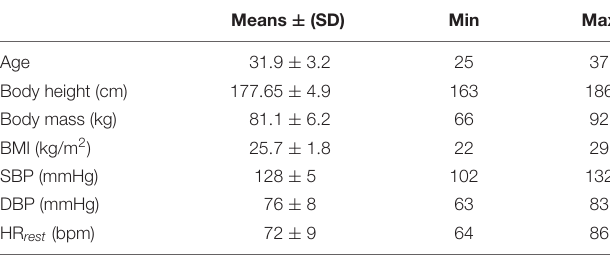
TABLE 1 | A characteristics of the study